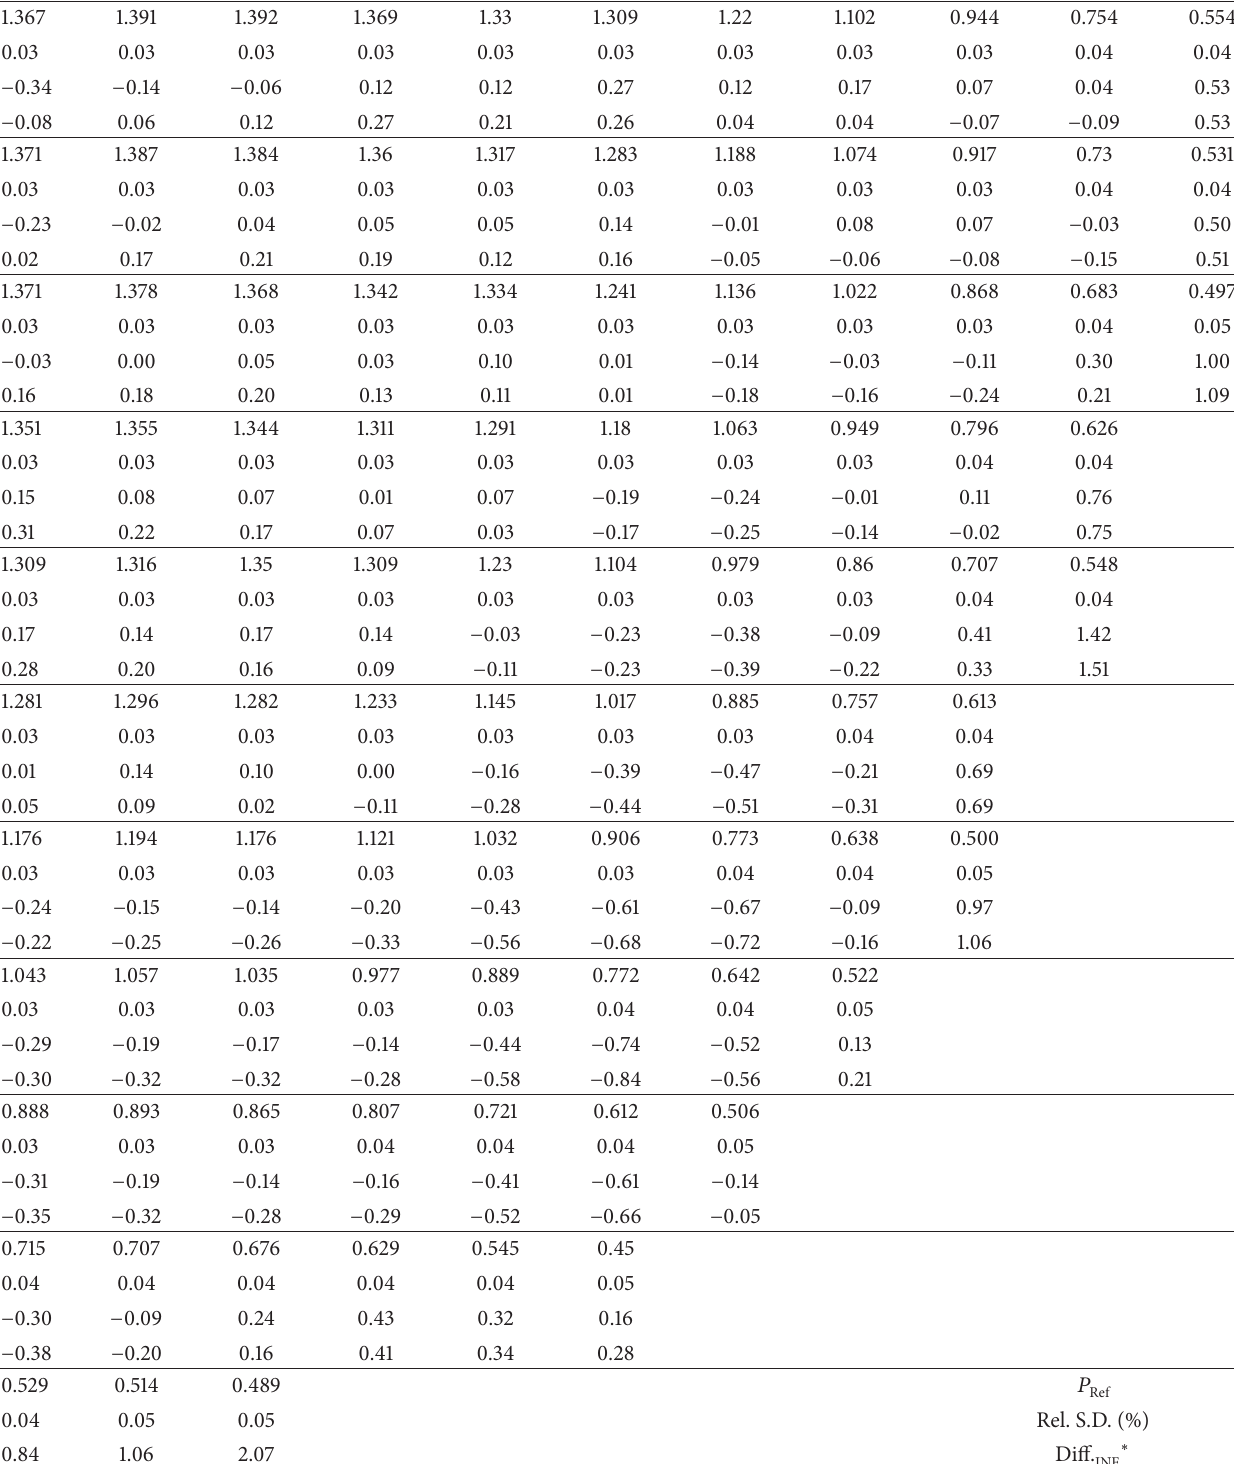
Table 7: Comparison of normalized channel power distribution for the core with LZCs at 50%